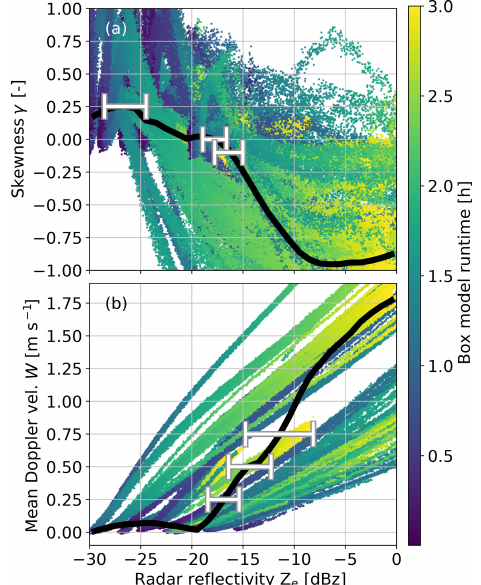
Figure 4. As in Fig. 3 but using ACME-V observations as the initial